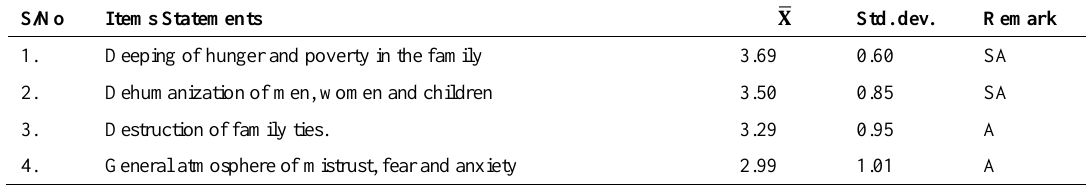
Table 3: Mean and Standard deviation of responses of respondents on the consequences of insecurity on the people of Enugu